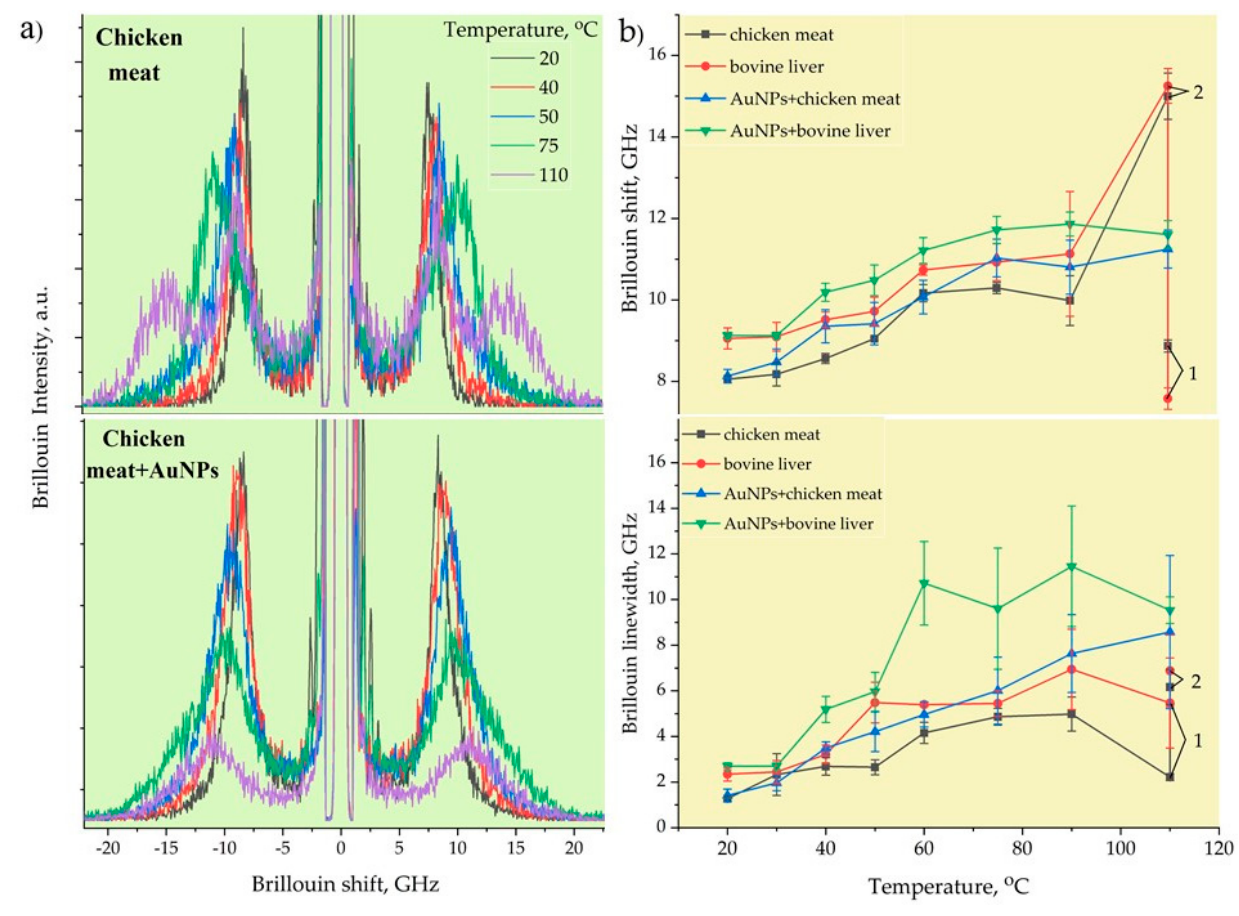
Figure 5. Typical Brillouin spectra of RF - ablated chicken muscle tissues without and with AuNPs ( a ). The Brillouin frequencies and linewidths of chicken meat and bovine liver with and without AuNPs ( b ).